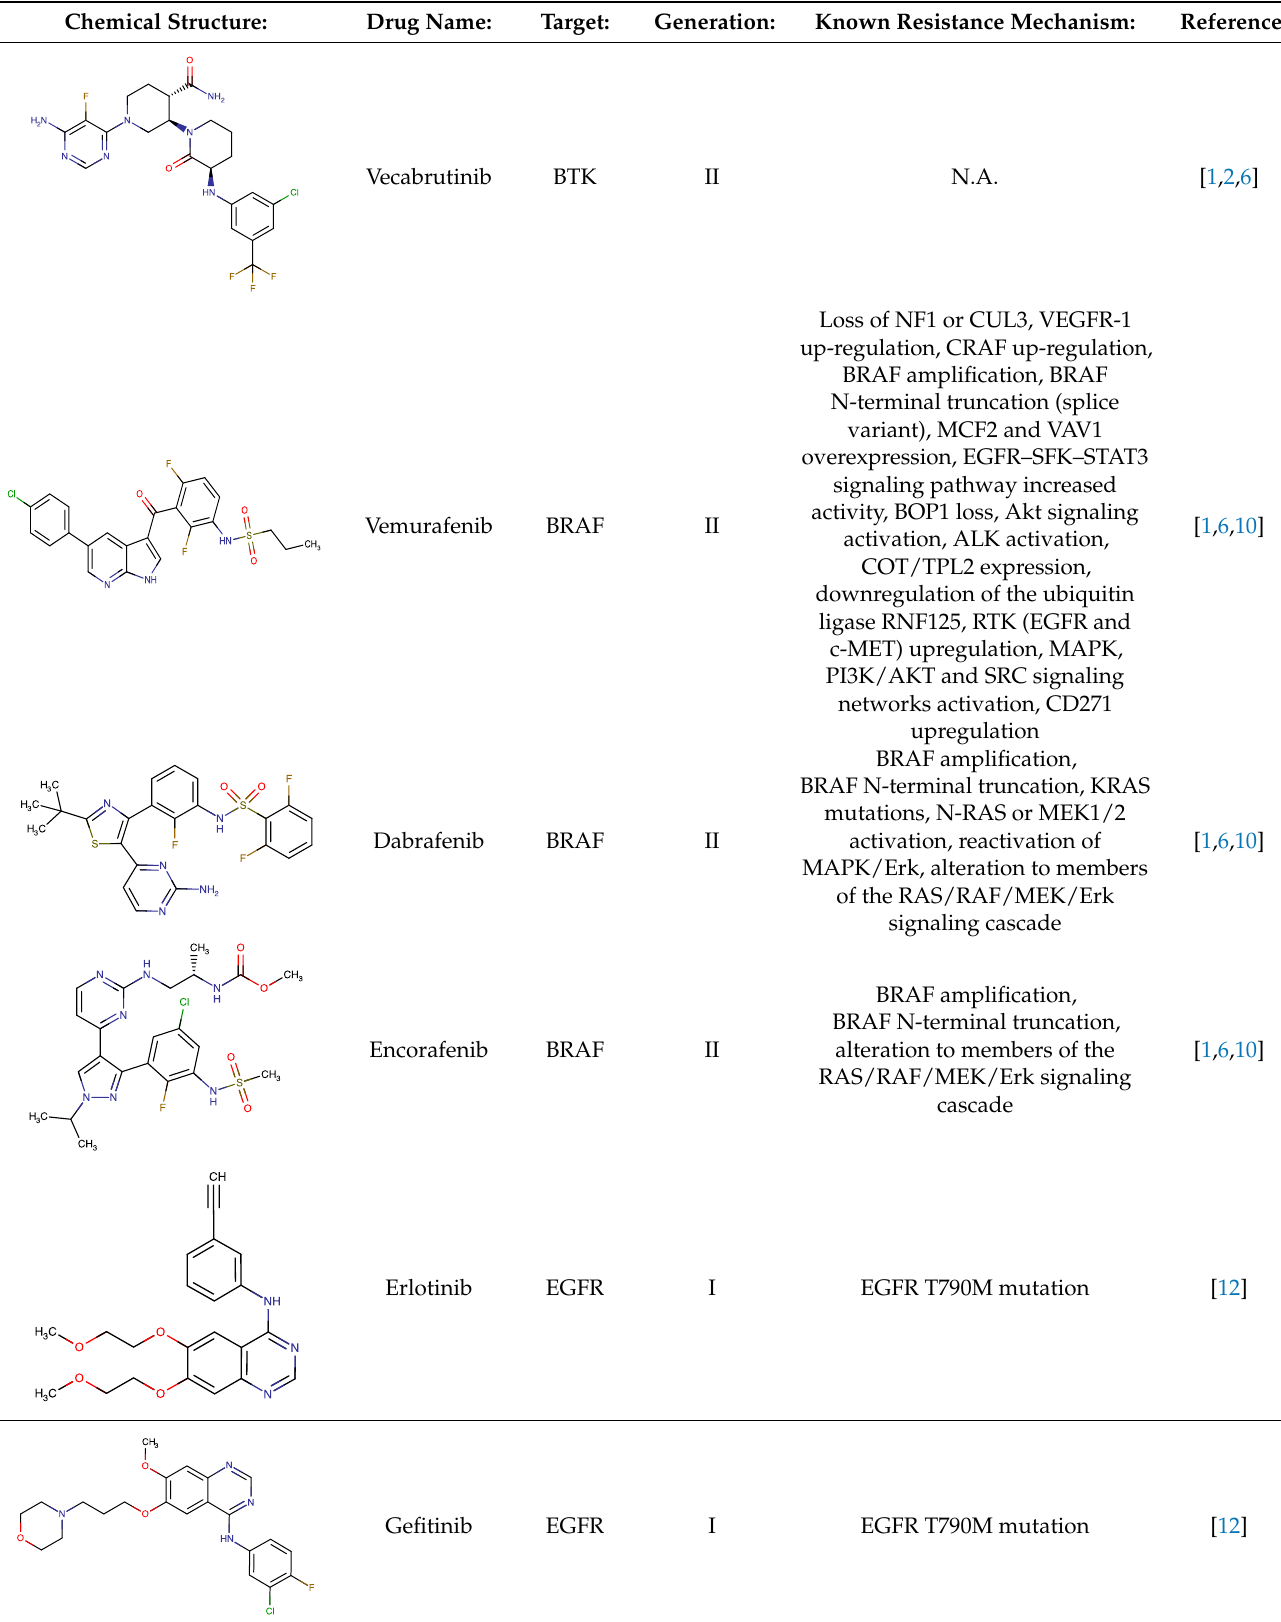
Table 1. Single kinase inhibitors currently available. Chemical Table 1. Cont.